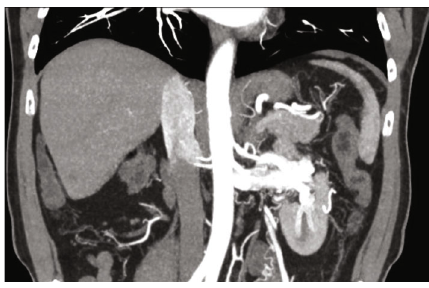
Figure 2: Coronal CT arterial phase showing two left renal arteries and early venous fi lling of contrast in renal vein and vena cava concerning for AVM in addition to multiple collateral vessels.